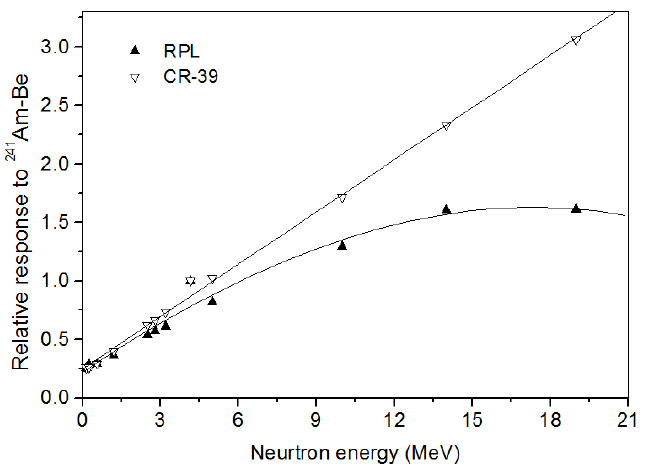
Figure 7. Relative energy response of the RPL and CR-39 detectors to fast neutrons.